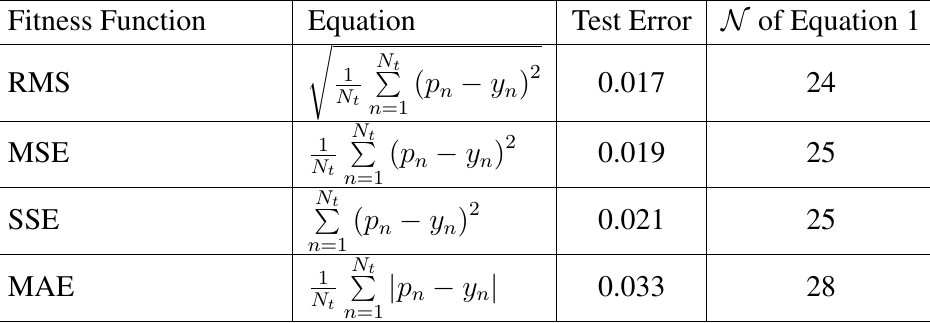
Table 1. Influence of several fitness functions on RBF